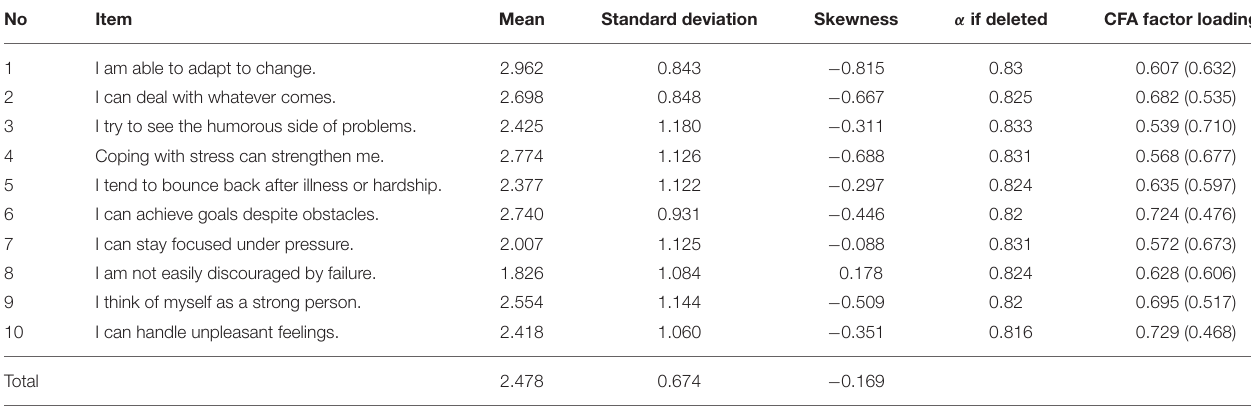
TABLE 1 | Descriptive statistics, reliabilities, factor loadings, and residuals (in parentheses) of the SD-RISC-10 items. No Item Mean Standard deviation Skewness α if deleted CFA factor loadings